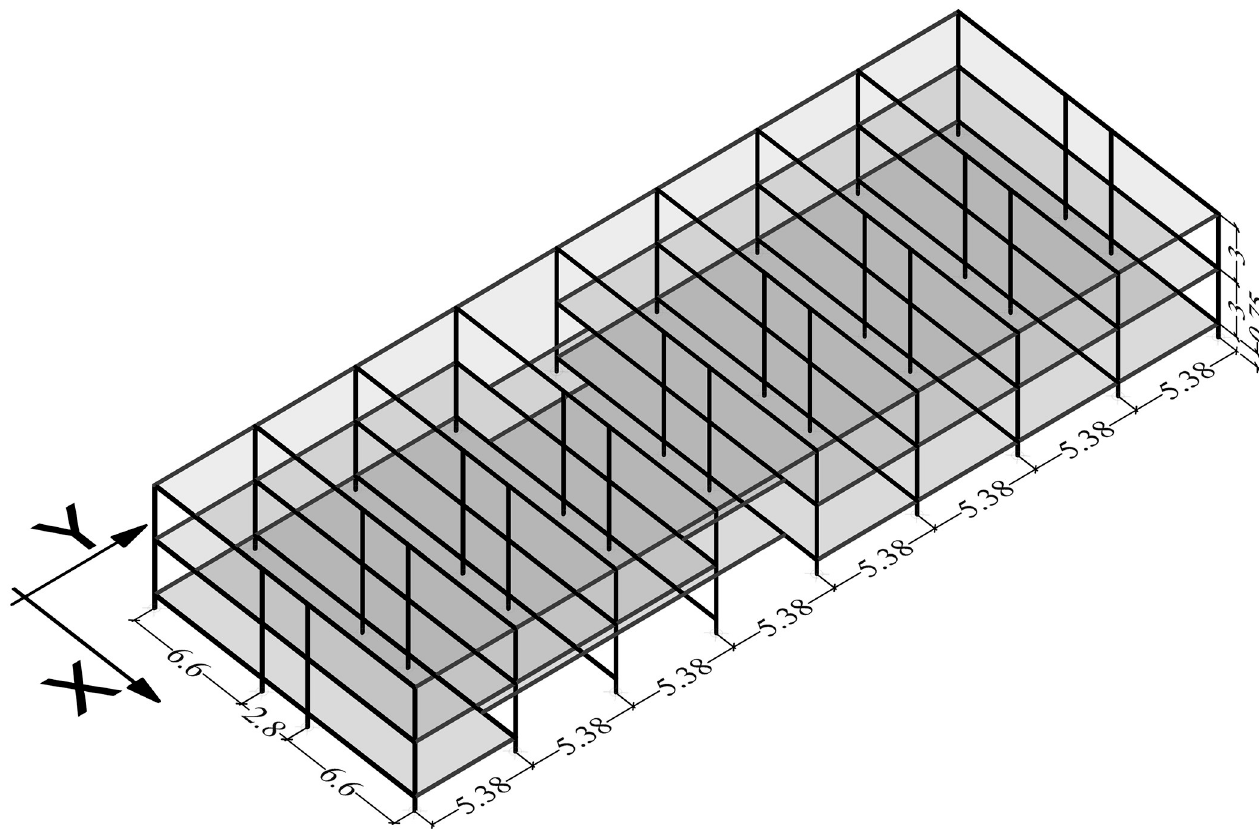
Fig 4. School’s configuration (dimensions in metres).